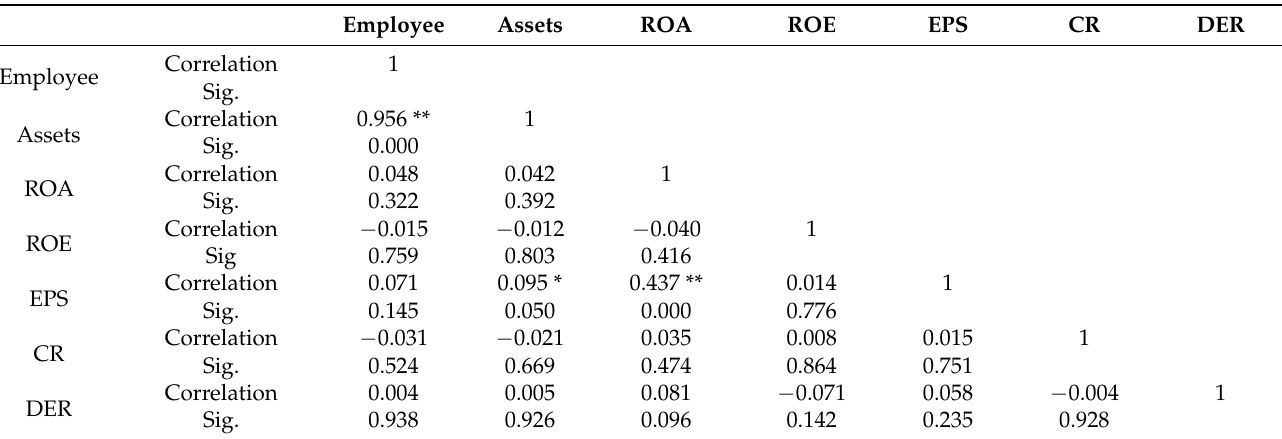
Table 4. Pearson correlations analysis.